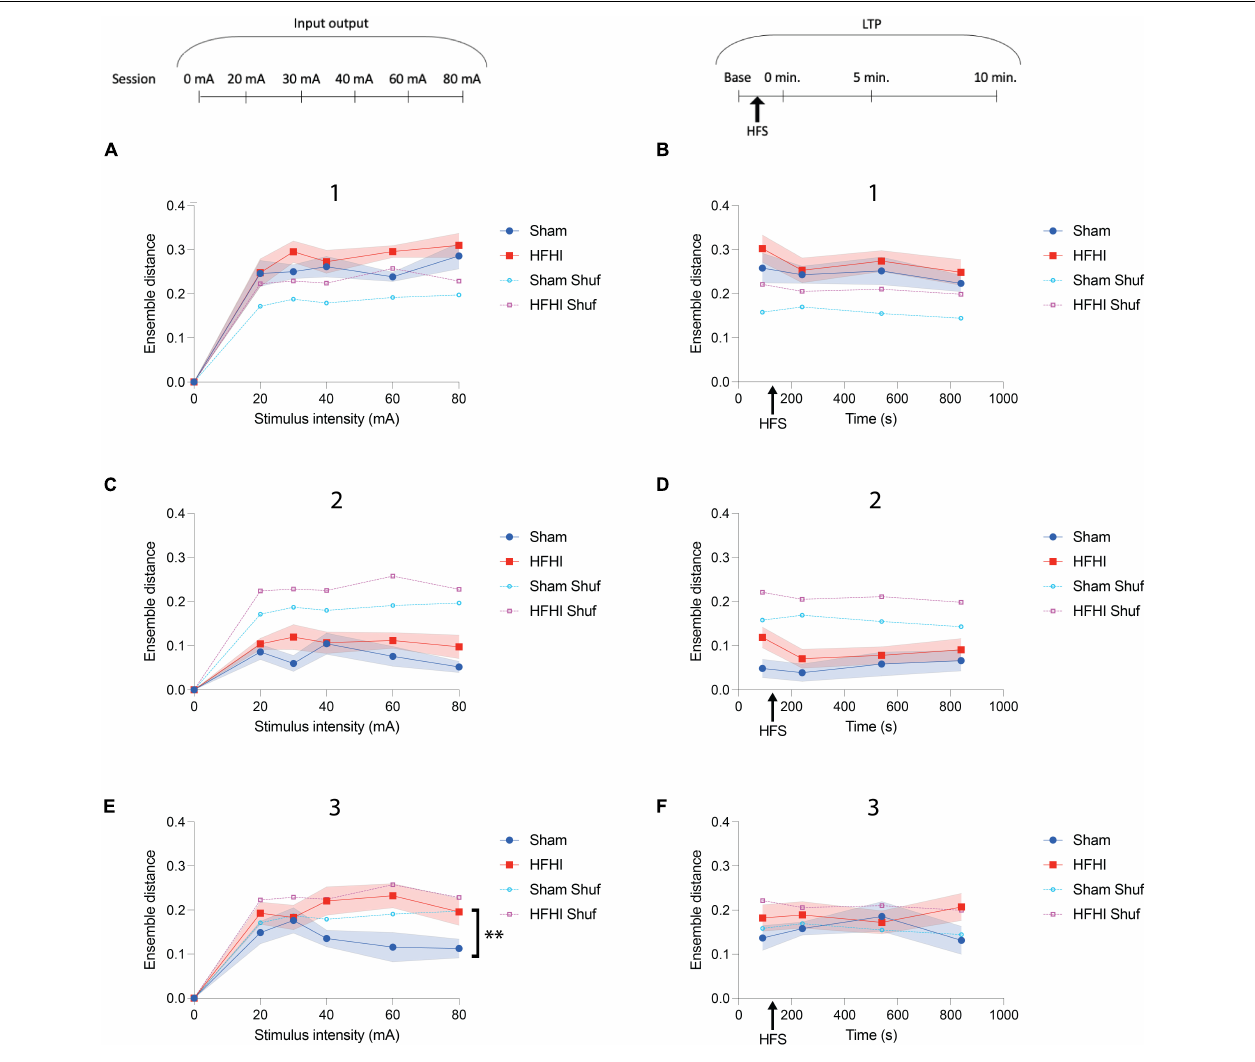
FIGURE 6 | High Frequency Head Impact (HFHI) increases post stimulus ensemble distance during second maximum. (A) HFHI slices displayed significantly increased ensemble distance during the first maximum during the 60 mA input output session, despite the mixed effects analysis not significantly differing between groups or (B) during the LTP sessions. (C) Ensemble distance during the minimum time range did not differ significantly between groups in the input output session, however, (D) during the LTP sessions HFHI displayed a trend toward increased ensemble distance. (E) During the second maximum, HFHI slices displayed significantly increased ensemble distance, especially at higher stimulus intensities, but (F) not during the LTP sessions. Mixed effects analysis, ** p < 0.01, comparing real data (non-shuffled) from each group, n Sham = 13, n HFHI =